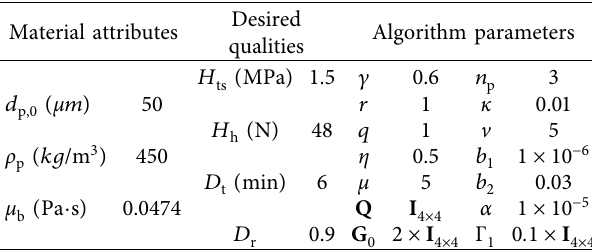
Figure 13: The experimental results for tabletting: the influences of moisture content. Table 3: The simulation conditions for process quality